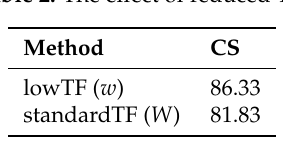
Table 2. The effect of reduced